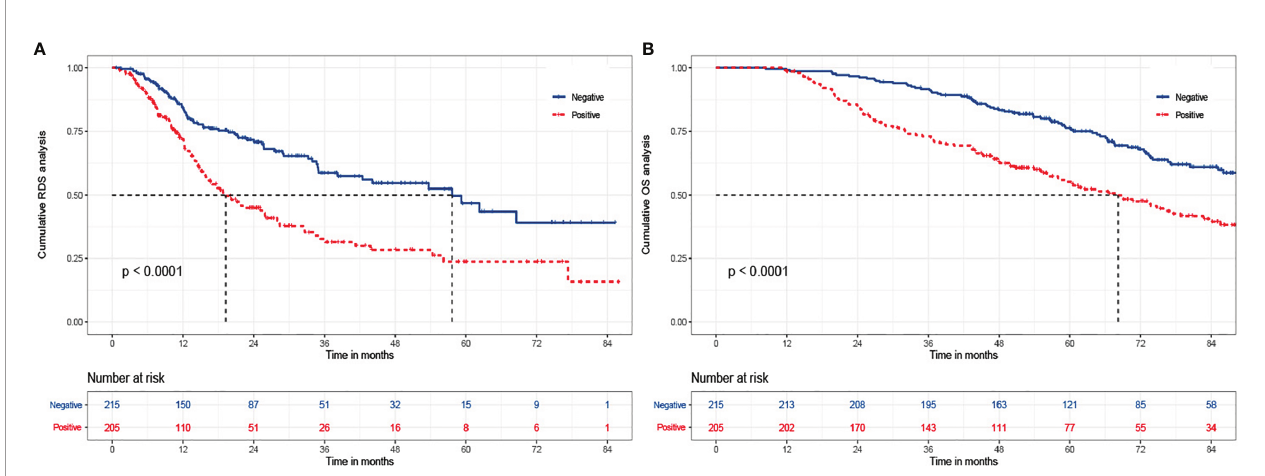
FIGURE 1 | The Kaplan-Meier analysis of RDS and OS for patients based on AFP at relapse. (A) is the Kaplan-Meier analysis of RDS; (B) is the Kaplan-Meier analysis of OS. RDS, recurrence-death survival; OS, overall survival.